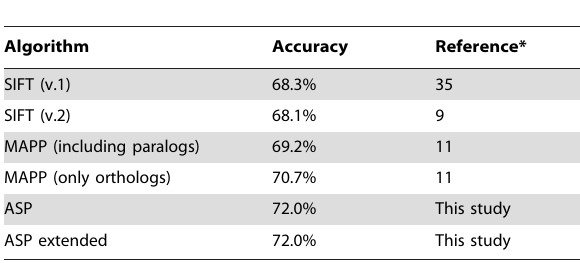
Table 2. Prediction accuracy of different algorithms on the LacI